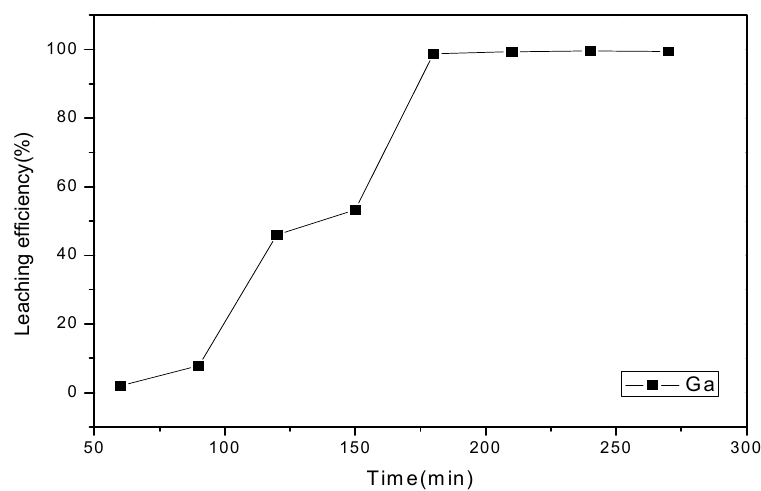
Figure 10. Effect of reaction time on the leaching efficiency of gallium in 0.25 M HCl with liquid-solid ratio 30 (mL/g) at 200 °C.